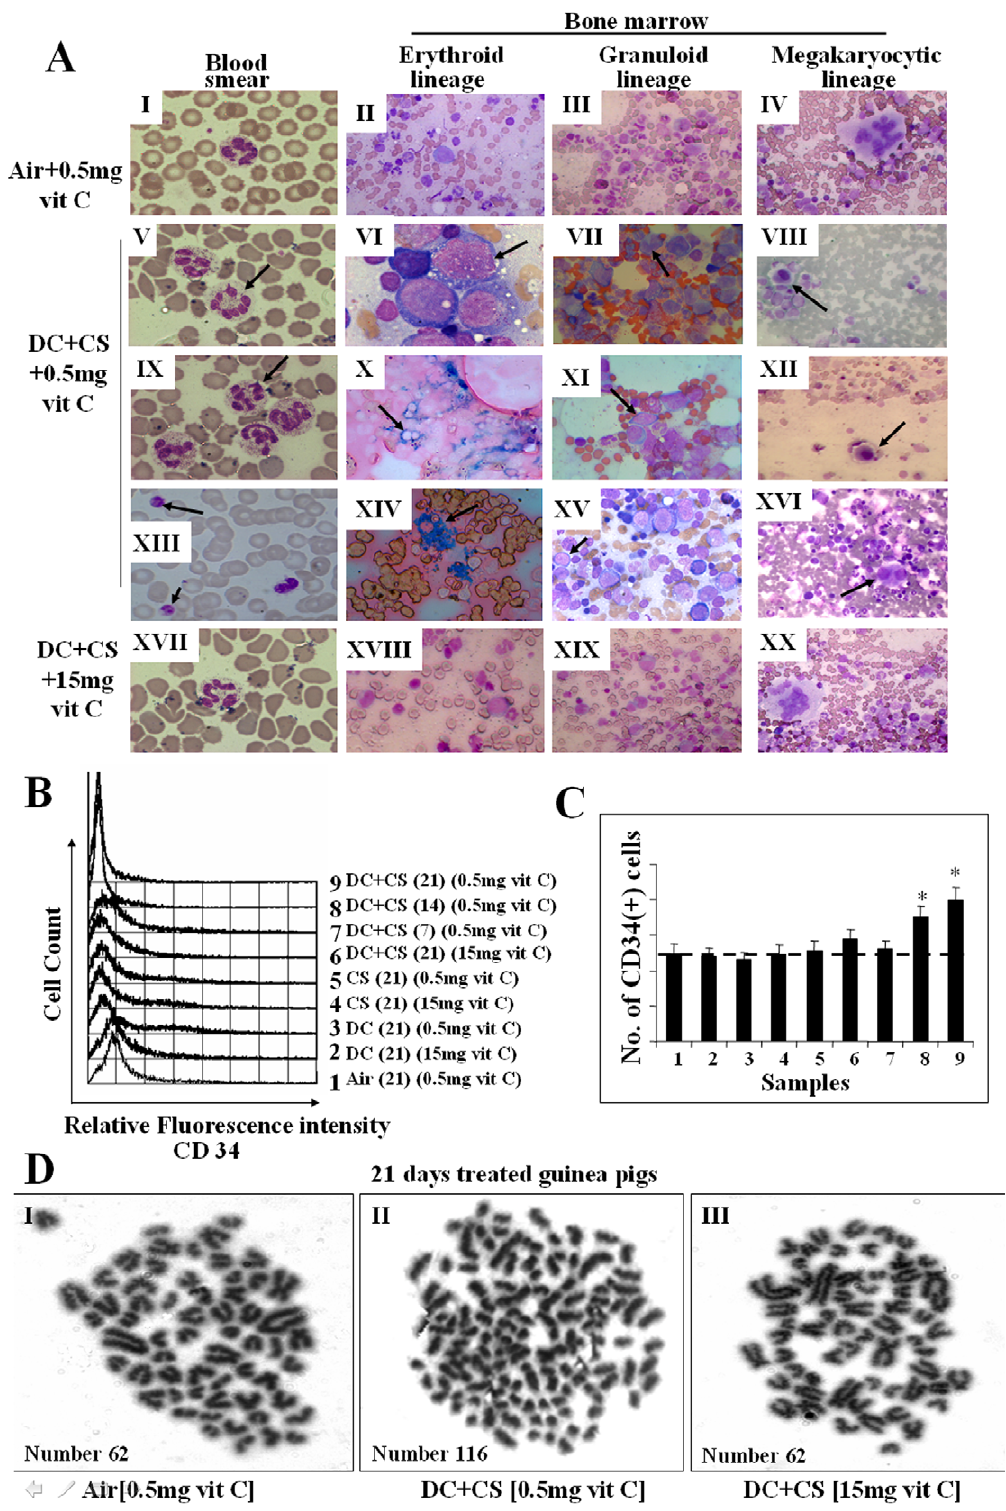
Figure 2. Identification of MDS in guinea pigs by blood and bone marrow cell morphology, measurement of CD34( + ) cells and cytogenetic studies. (Panel A ) Differential staining showing some typical changes in blood and bone marrow cell morphology of MDS guinea pigs and its prevention by feeding the animals 15 mg vitamin C/day. A, I–IV , represent sham controls (fed 0.5 mg vitamin C/day and exposed to air); A, V–XVI , represent MDS guinea pigs (CS-exposed fed DC and 0.5 mg vitamin C/day); A, XVII–XX , represent CS-exposed guinea pigs fed DC and 15 mg vitamin C/day. Blood smear - Leishman stain; bone marrow aspirate - Wright Geimsa stain, except Perls’ stain in X and XIV; (magnification 400 6 , except I, V, VI, IX, XIII, XVII; 1000 6 magnification). R indicates dysplastic cells. Vit C means vitamin C. (Panel B) Measurement of CD34( + ) cells in